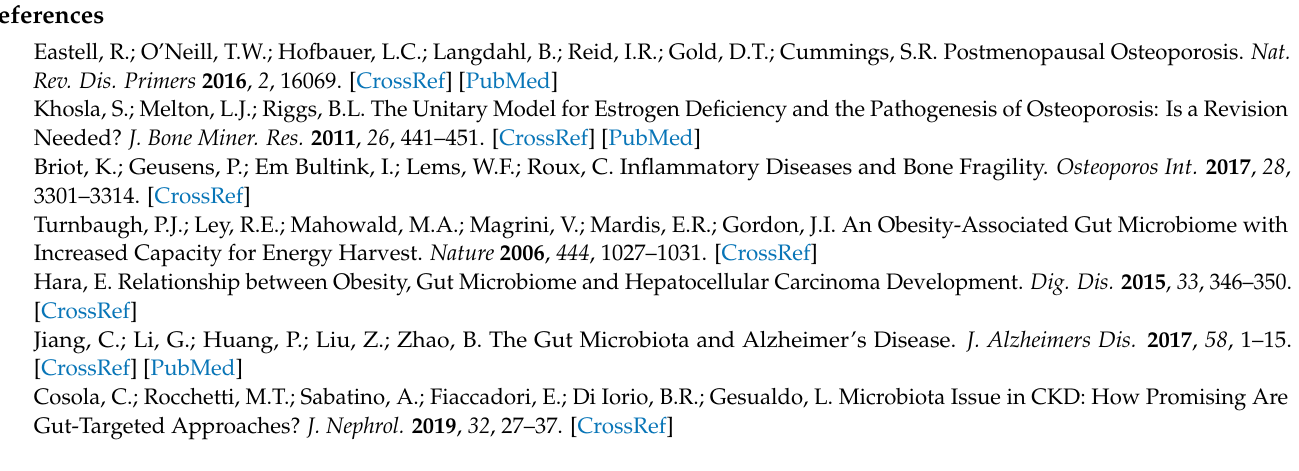
Figure S2: The mRNA expression level of TNF α and ZO-1 in the small intestine, Figure S3: Changes in small intestinal microbiota after ovariectomy, Table S1: The PCR primers and TaqMan probes, Table S2: The cecal bacterial composition at the species